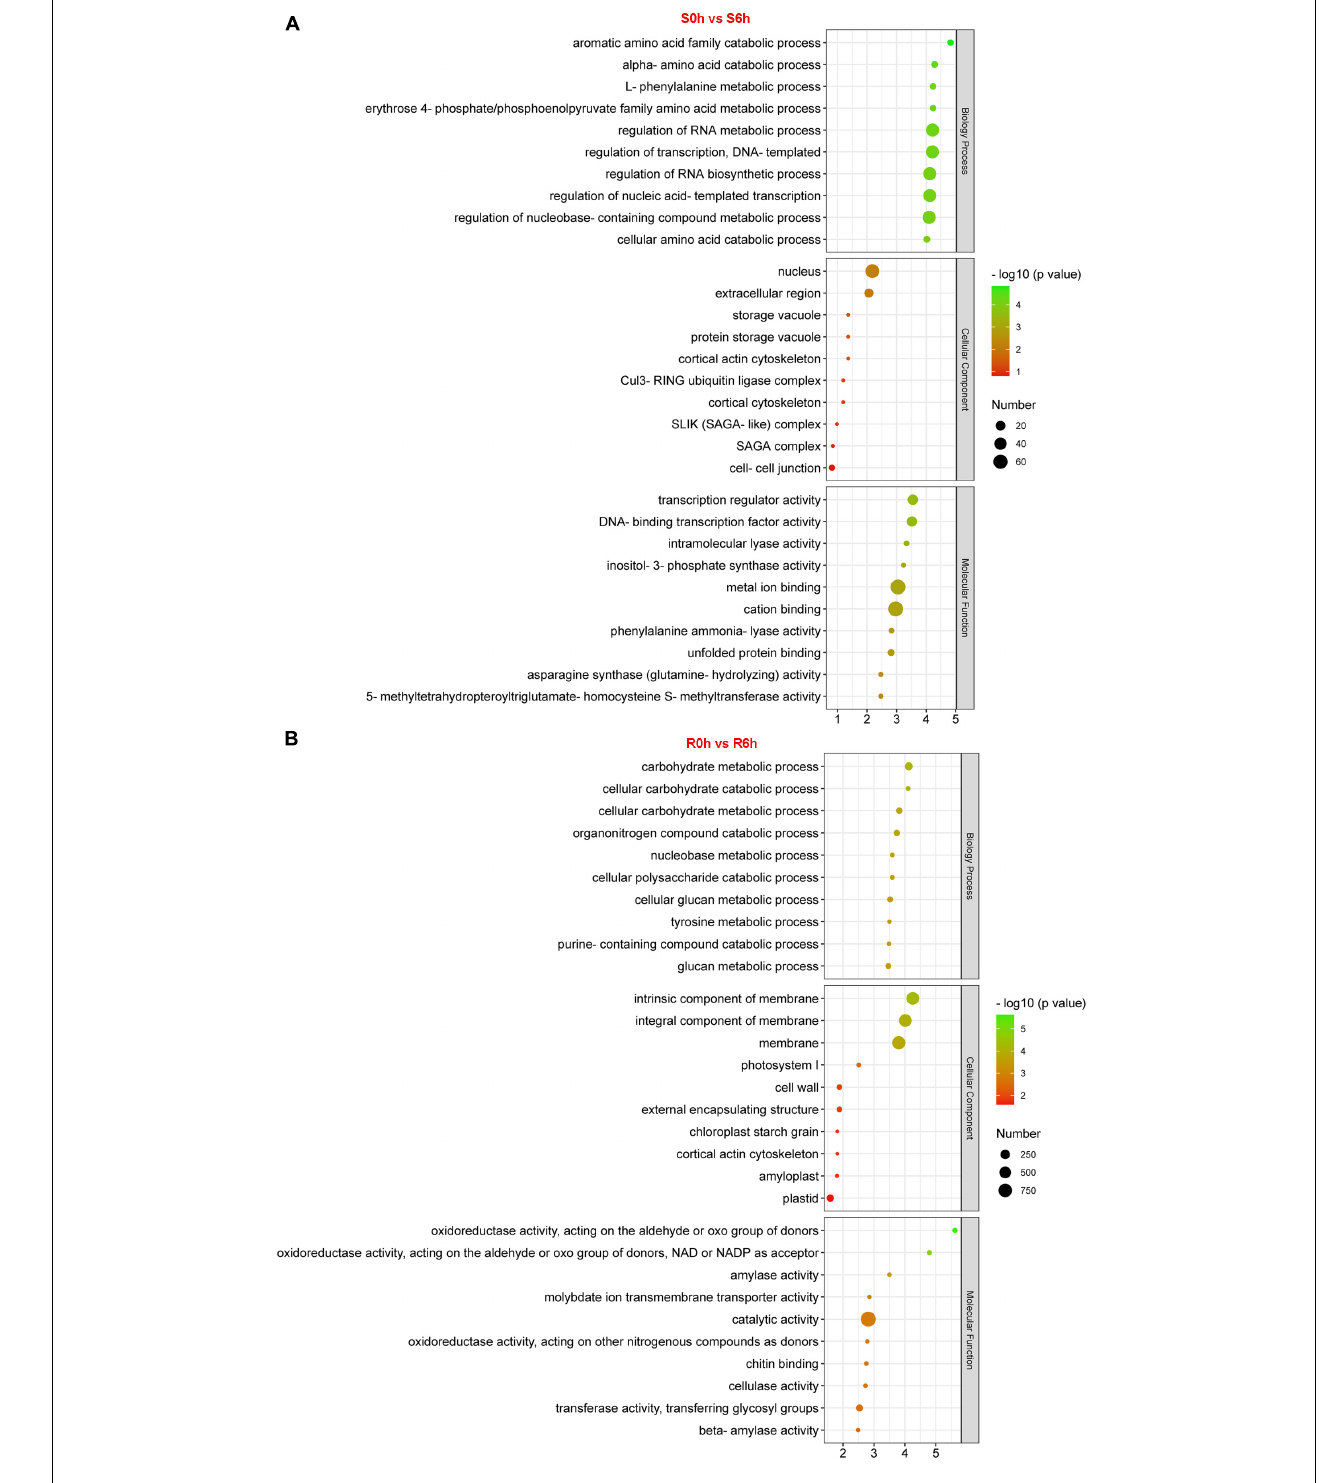
FIGURE 3 | GO enrichment analysis of DEGs in PM-susceptible cucumber B21-a-2-2-2 (A) and PM-resistant cucumber B21-a-2-1-2 (B) subjected to P. xanthii . The results from the biological process, cellular component and molecular function categories are summarized.